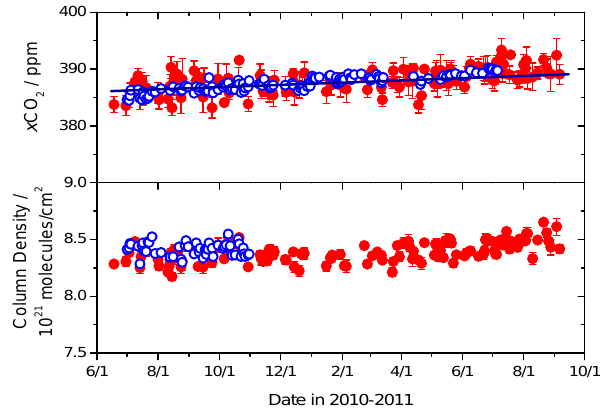
Fig. 5. Time series of column density and x CH 4 with the standard deviations for 14 months at UoW in Australia. OSA: solid circles (SF=1.035); FTS: open circles (SF=0.978).